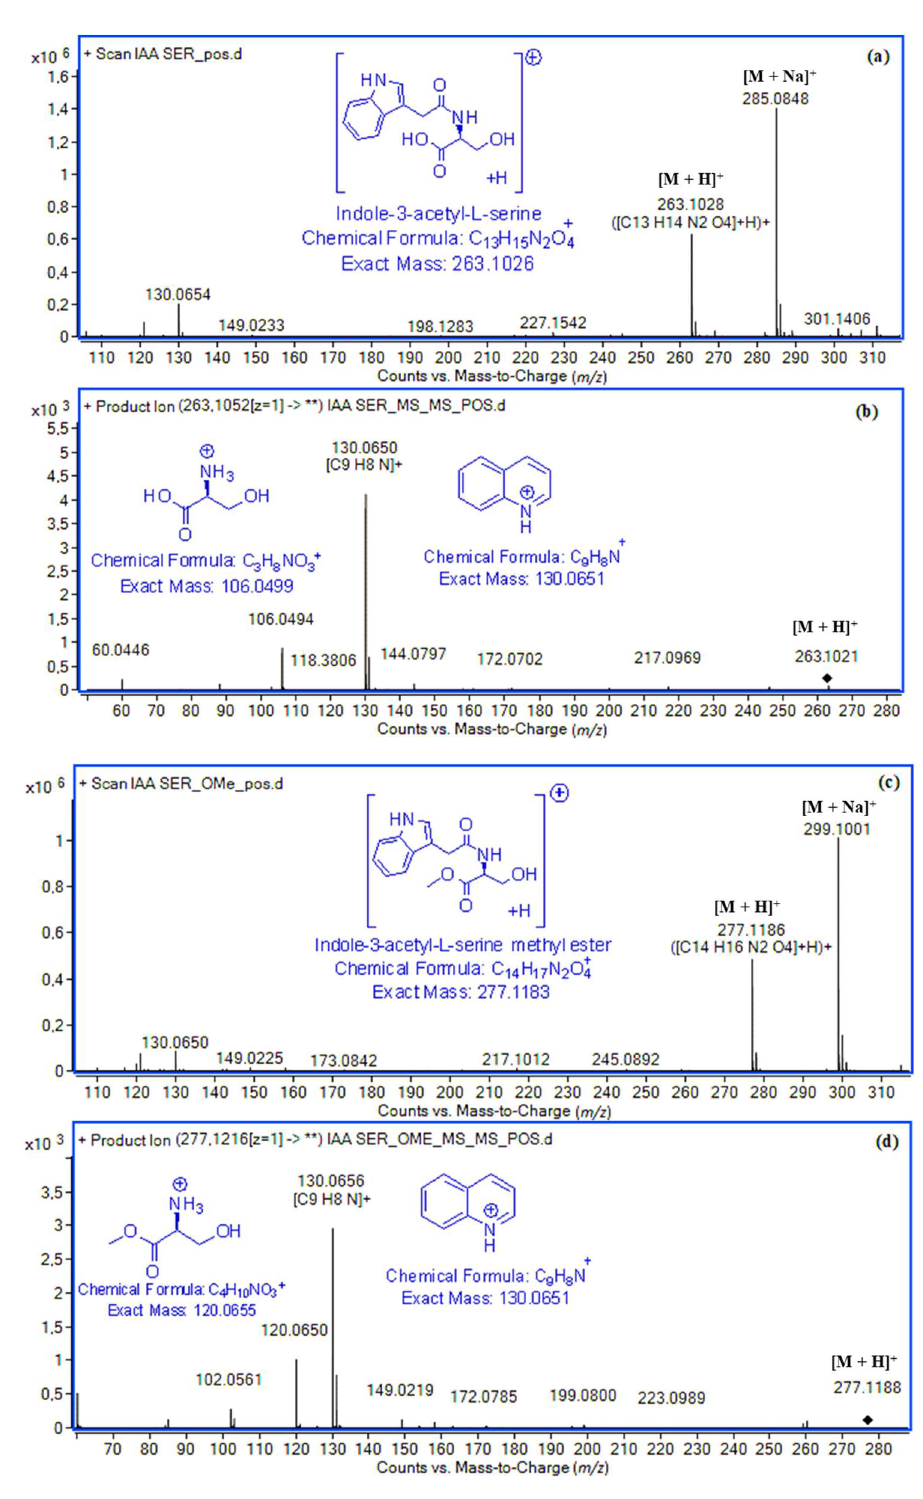
Figure 3. ( a ) Full scan and ( b ) MS / MS spectra of indole-3-acetyl- l -serine in positive electrospray ionization (ESI) mode. ( c ) Full scan and ( d ) MS / MS spectra of indole-3-acetyl- l -serine methyl ester in positive ESI mode.